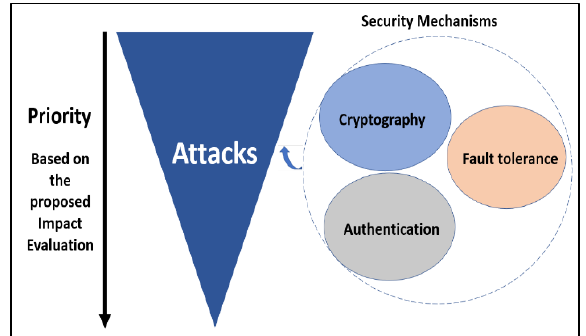
Figure 10. The adopted security strategy based on our impact